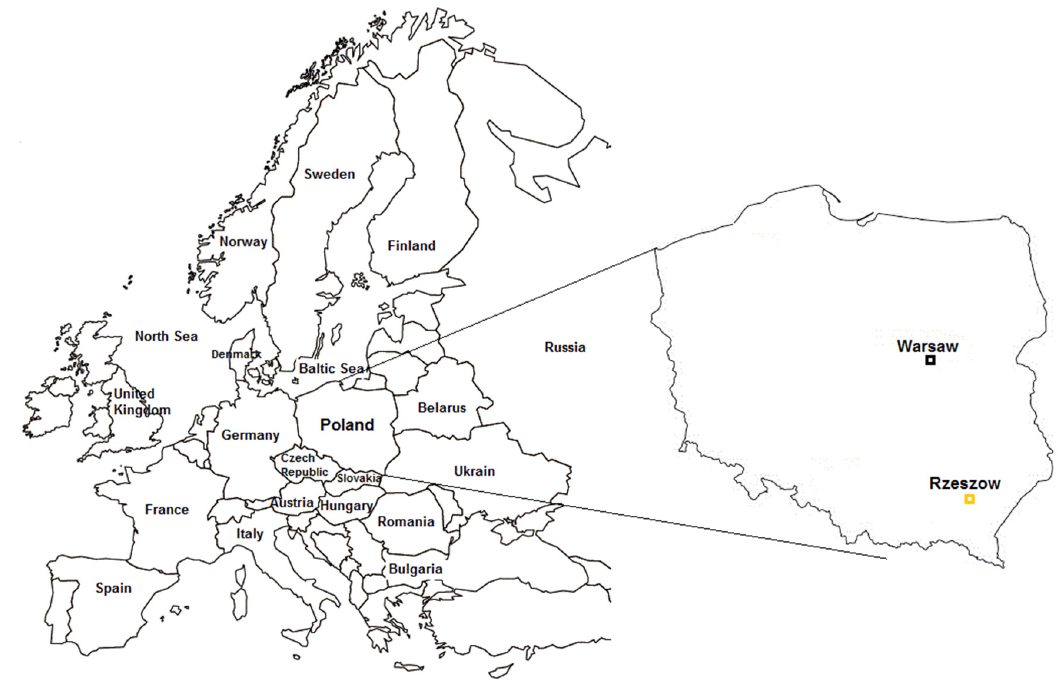
Figure 1. Location of the case study city in Poland. Buildings 2019 , 9 , x FOR PEER REVIEW